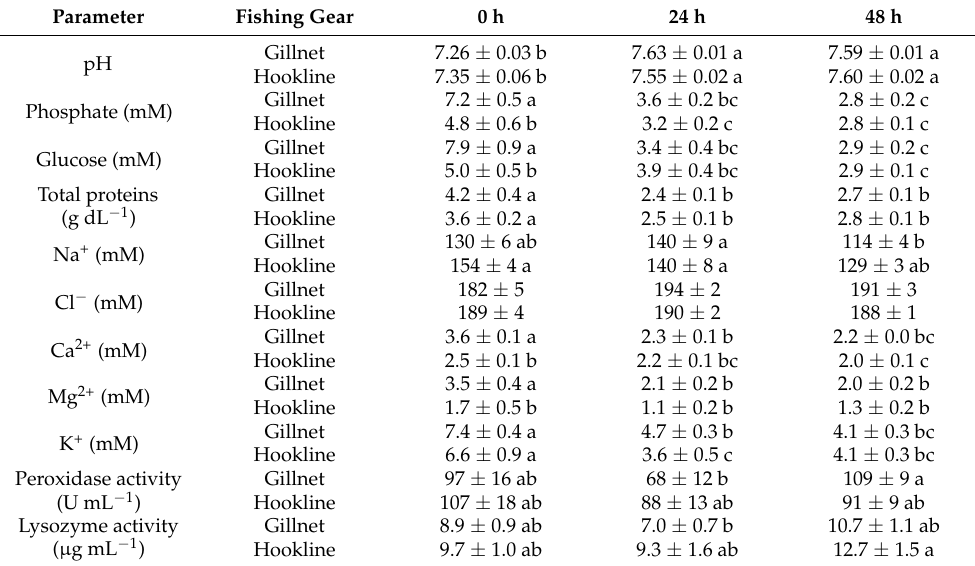
Table 1. Serum pH, energy metabolites, and ions in P. mediterraneus captured by gillnet or hookline. Fish were sampled immediately after capture (0 h) or at times 24 h and 48 h after their introduction into floating sea cages. Data are expressed as mean ± SEM ( n = 8–25 per group and time). Different lowercase letters indicate significantly different groups ( p < 0.05, two-way ANOVA followed by a post hoc Tukey test).